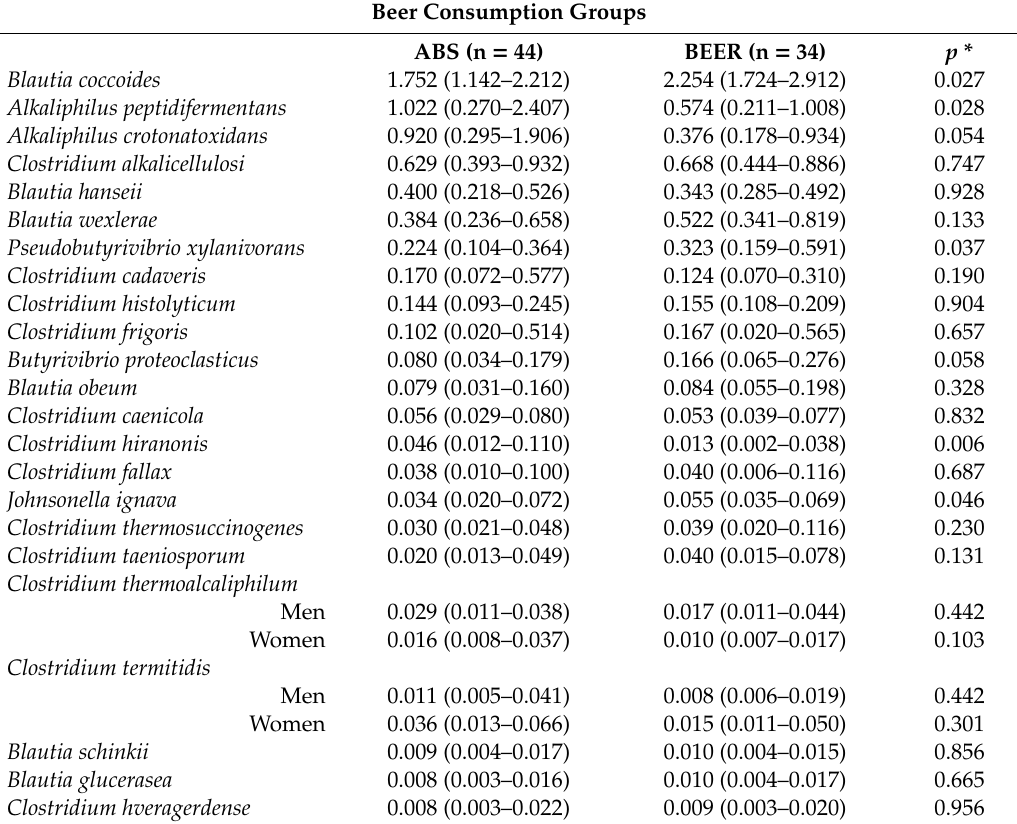
Table 4. Relative abundances [%] of bacterial species in moderate beer consumers and Table 4 . Relative abundances [%] of bacterial species in moderate beer consumers and abstainers.